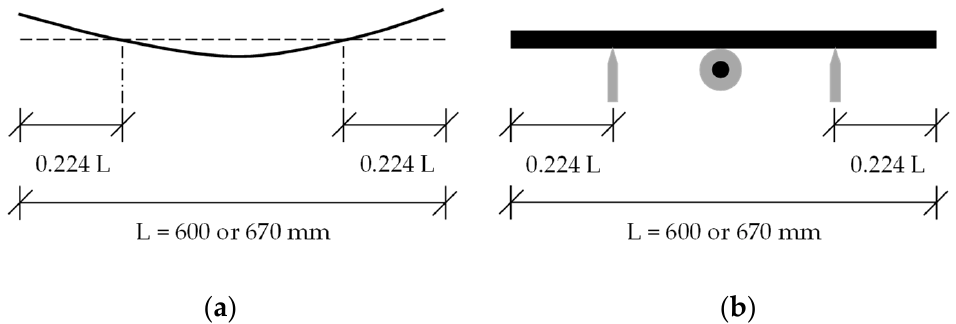
Figure 8. Alignment of the supports, ( a ) the 1st mode shape of beam with free ends; ( b ) point-supported beam with a core-coating element at mid-span.